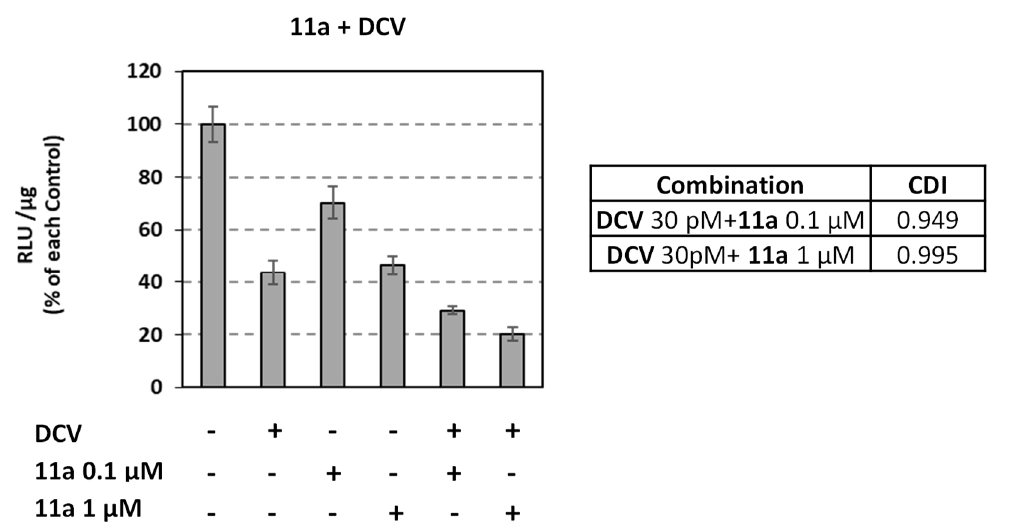
Figure 5. Combinatory activity of 11a with DCV against HCV GT 1b (Con1). Huh5-2 cells were treated or not with the analogue in the presence or absence of 30 pM DCV. F-Luc activity was measured and expressed as RLU per µ g of total protein. Values from compound-treated cells were expressed as percentage of those derived from cells treated with the solvent DMSO (control—C). CDI: Coefficient of drug interaction. Bars represent mean values obtained from three independent experiments in triplicate. Error bars represent standard deviation (SD).